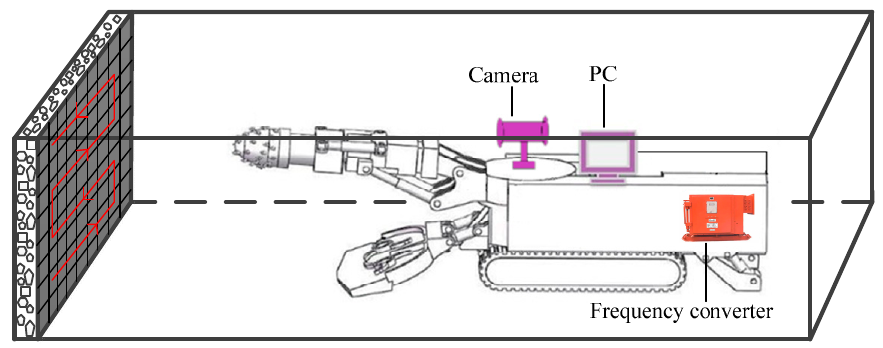
Figure 1. Vision control system of roadheader .